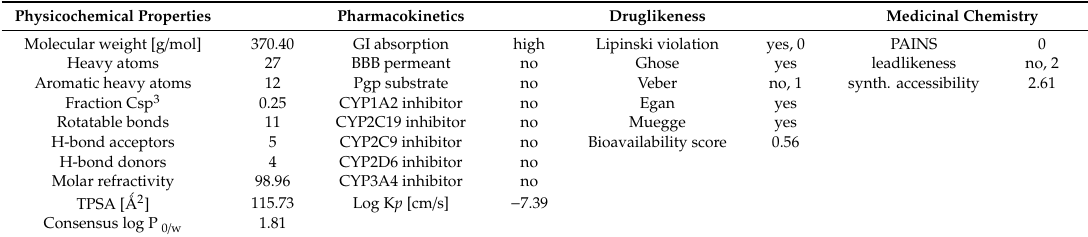
Scheme 1. Outline of the s ynthesis of compound 1 .